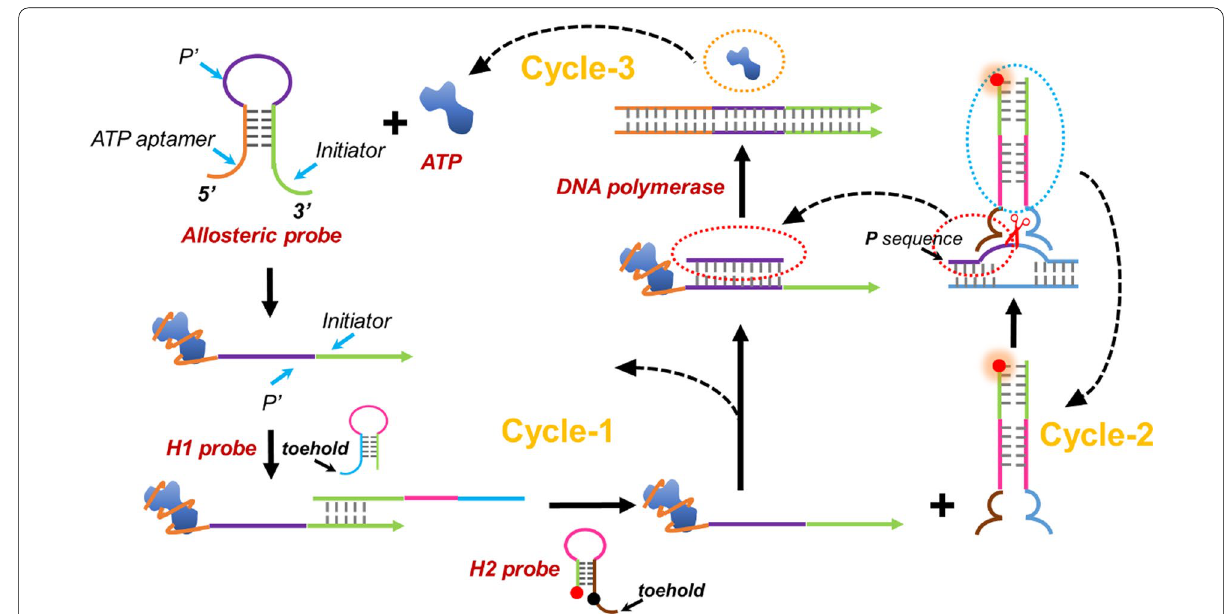
Fig. 1 a The working mechanism of the proposed